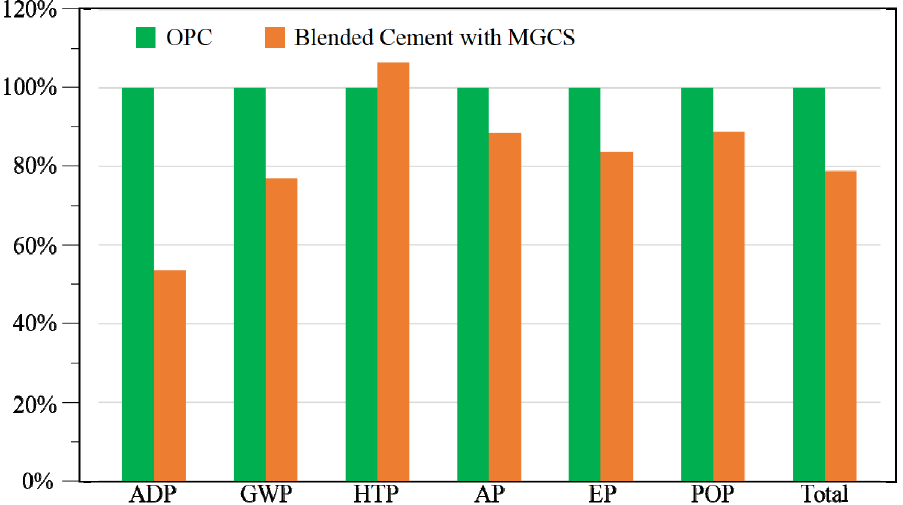
Figure 7. Comparison of LCA results between OPC and blended cement.